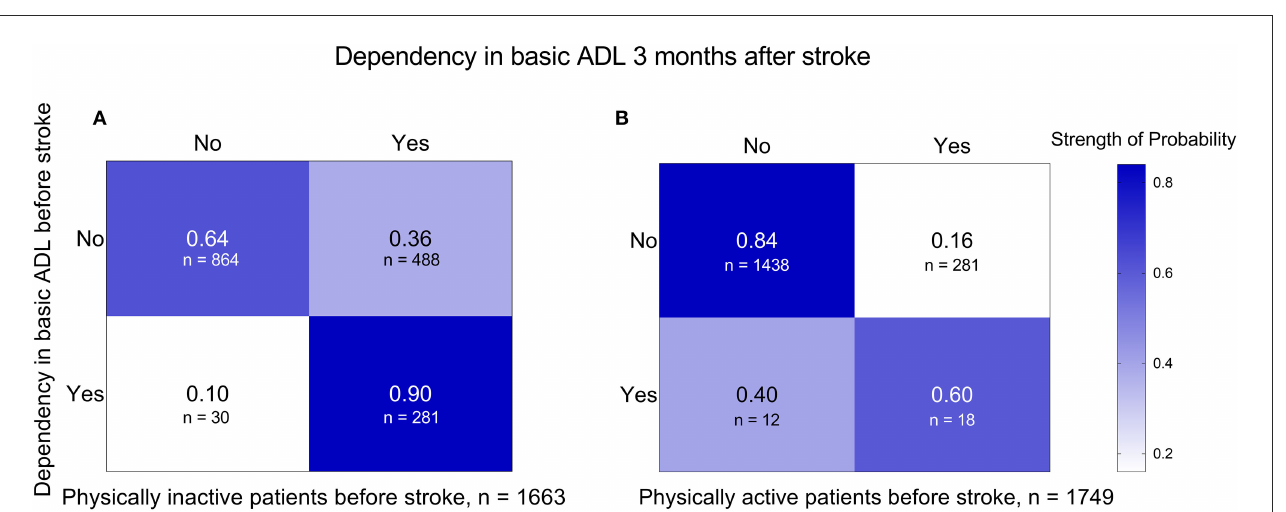
FIGURE3 Transition probabilities from basic ADLs before stroke to basic ADLs 3 months after stroke in subgroups of patients who were physically inactive (A) and physically active (B) before stroke. ADL, activities of daily